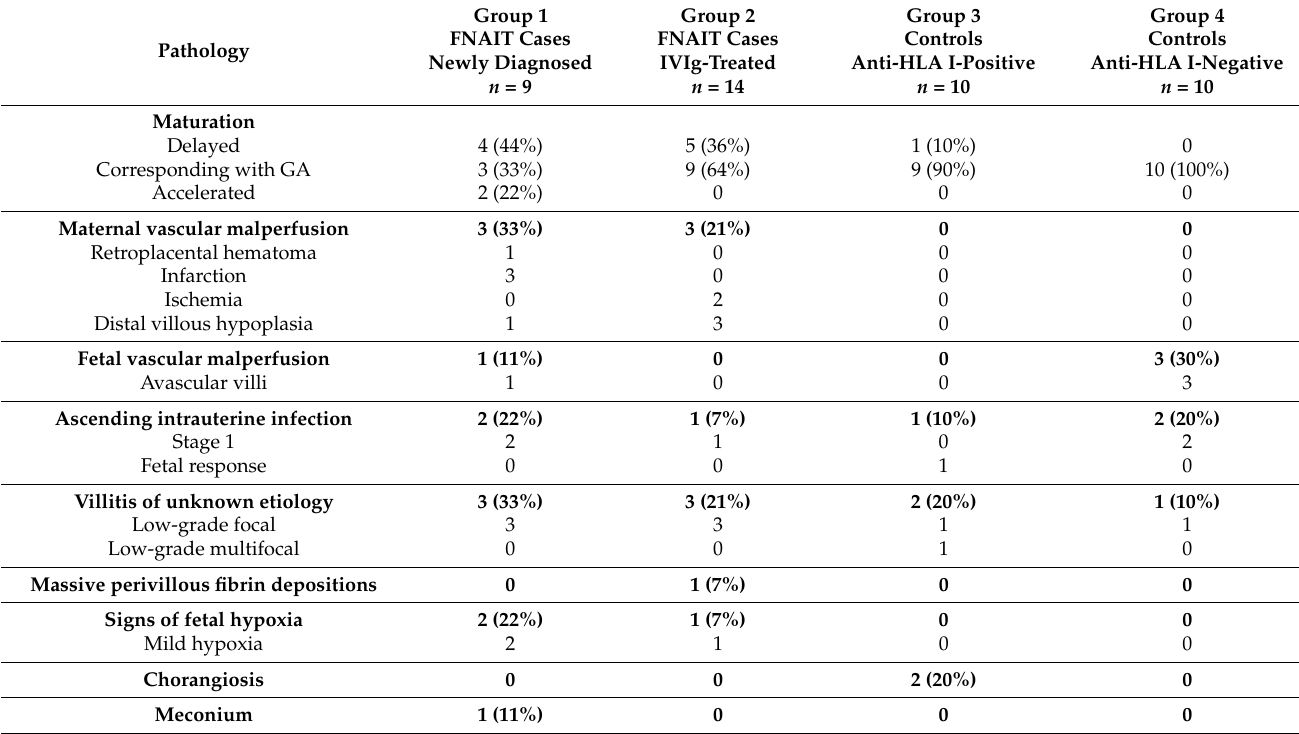
Table 2. Placenta